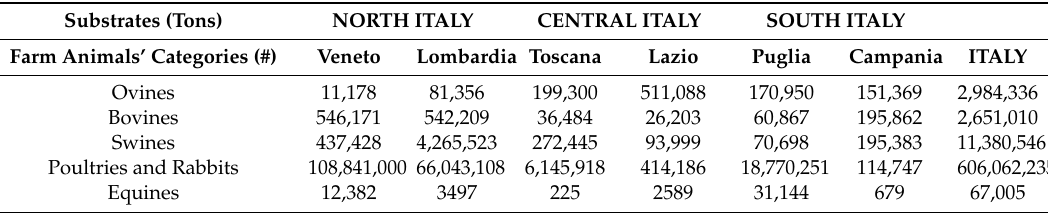
Table 2. The number of animals farmed in the selected Italian regions grouped in di ff erent categories. Substrates (Tons)